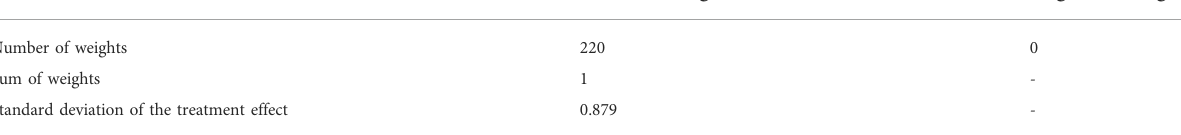
TABLE 2 Estimation of